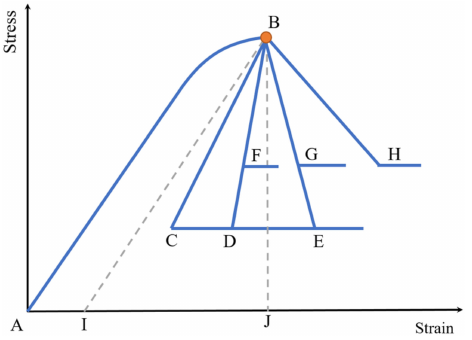
Figure 2. Schematic diagram of rock stress–strain with different post-peak curves. Note: A is the starting point; AB is the pre-peak stress–strain curve; BC, BD, BE, BF, BG, and BH are different post-peak curves; AI is the unrecoverable axial strain; and BJ is the boundary between two types of